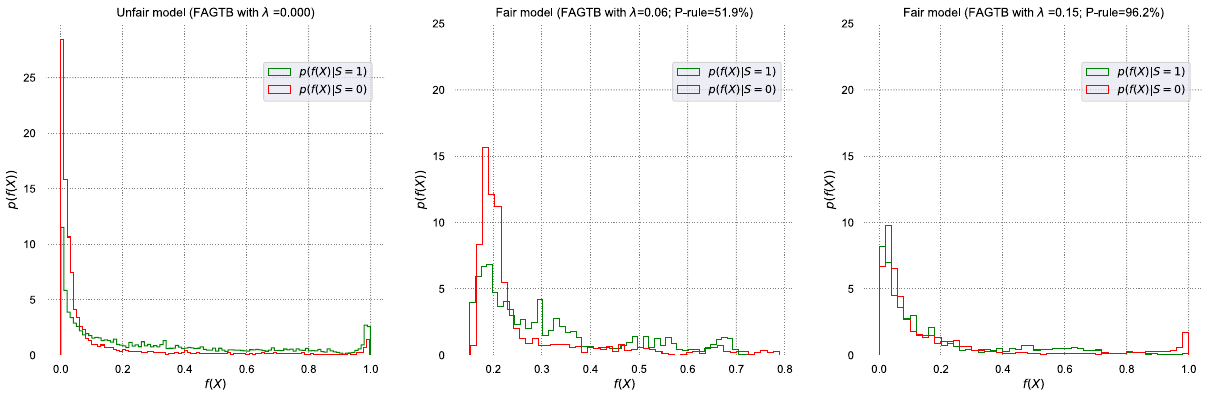
Fig. 5 Distributions of the predicted probabilities given the sensitive attribute S (Adult UCI data